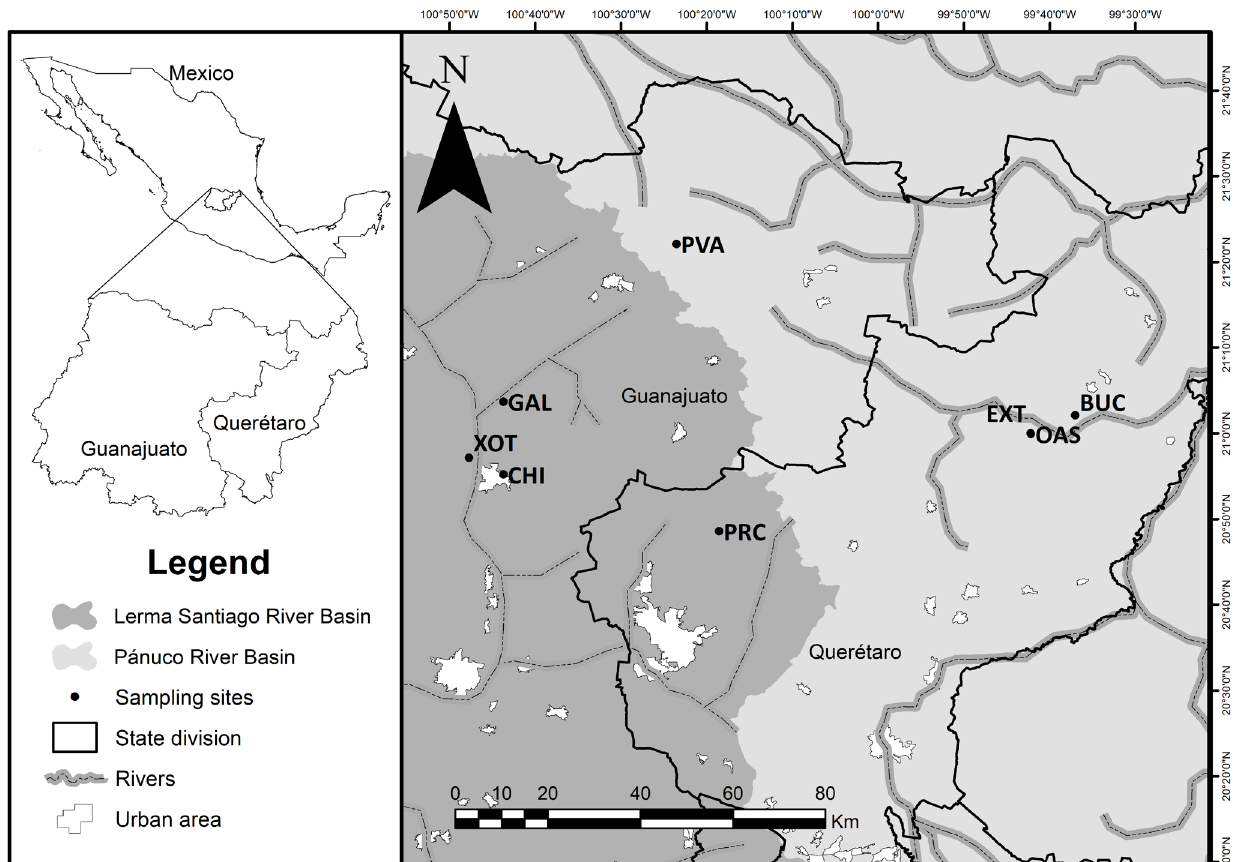
FIGURE 1 | Geographic location of study area and sampling sites located in the Lerma-Chapala River basin and Pánuco River basin in central Mexico. XOT = El Xote; CHI = El Charco del Ingenio; GAL = Los Galvanes; PRC = Presa del Carmen; PVA = Paso de Vaqueros; OAS = Oasis; EXT = Extoraz; BUC =